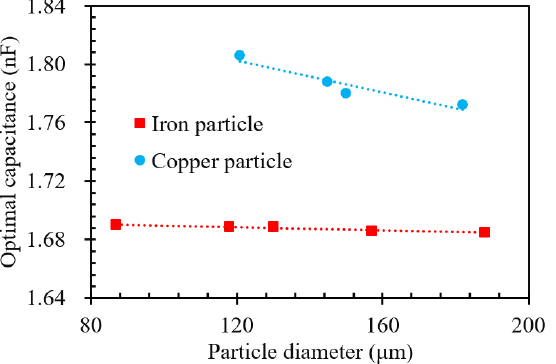
Figure 5. The optimal capacitance for the detection of different sizes of iron and copper particles.